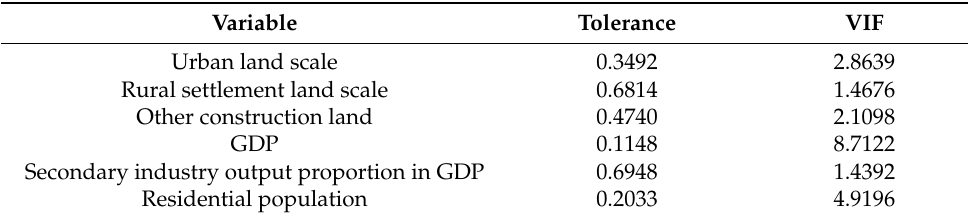
Table 2. Results of collinearity test for factors influencing carbon emissions in Southwest China. Variable